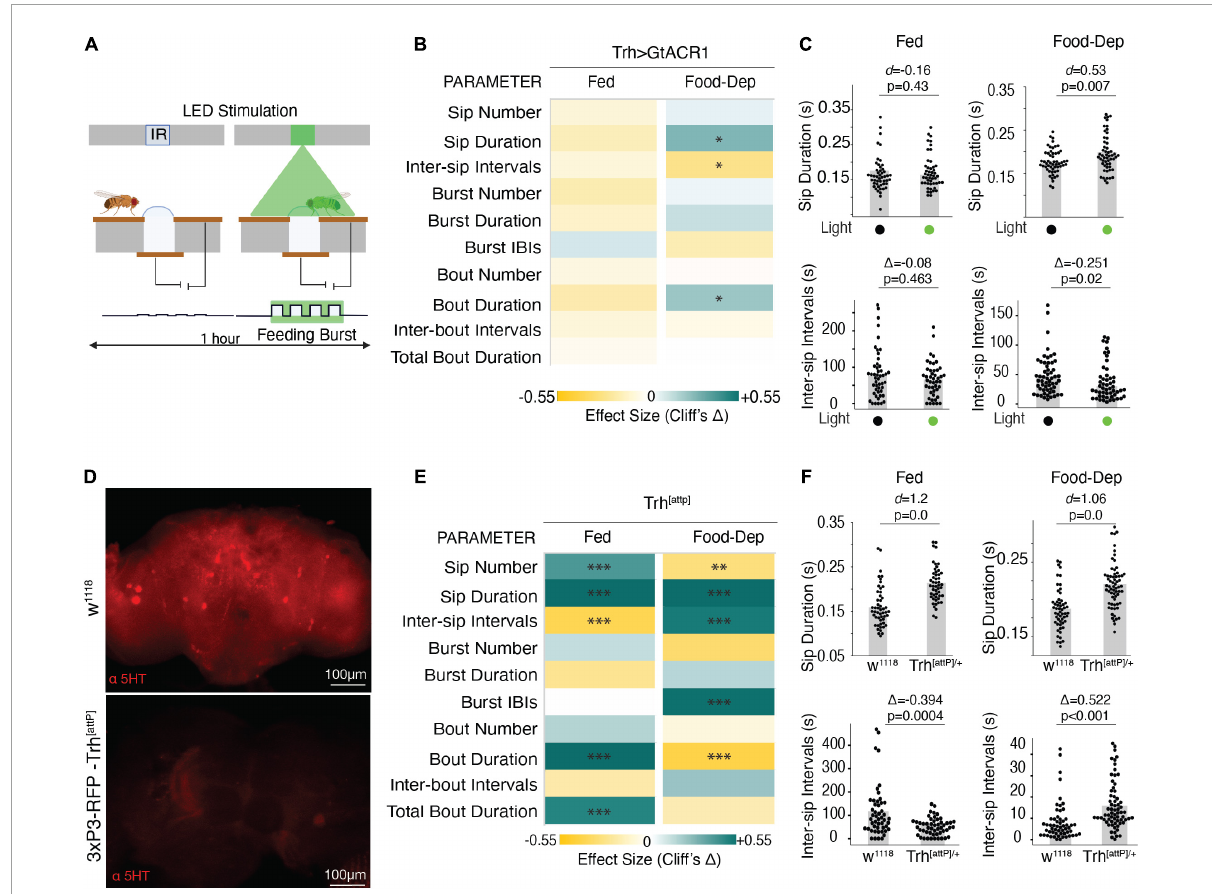
FIGURE4 The inactive serotonergic system enhances feeding. (A) Schematic depicting the closed-loop OptoPAD system used for optogenetic inactivation of serotonergic neurons as the fly starts to feed. The green illumination lasts for 2 s after the start of the activity bout. (B) Heat maps showing Cliff’s (cid:49) effect sizes for all the parameters measured by the OptoPAD system for Trh-Gal4 > UAS-GtACR1 with and without green illumination for the fed state and the food-deprived state. (C) Cumming estimation plots showing Cohen’s d for mean sip durations and Cliff’s (cid:49) for inter-sip intervals of Trh-Gal4 > UAS-GtACR1 flies in the fed state (left) and food-deprived state (right) with and without optogenetic activation during the assay time (3,600 s). Inactivation of Trh neurons at 100 uW/mm 2 increased the sip duration [ n = 54–55, d = 0.53, (95% CI 0.15, 0.89), p = 0.0074] and decreased the inter-sip intervals [ n = 52–57, (cid:49) = –0.265 (95.0% CI –0.46, –0.03), p = 0.018] in the food-deprived state. (D) Maximum intensity projections of anti-5-HT staining of fly brains with normal expression of Trh (wild-type) and flies carrying the attP mutation. (E) Heat map showing Cliff’s (cid:49) effect size for the parameters measured by the OptoPAD system for Trh-attp/ + compared to w 1118 controls for the fed and food-deprived states. (F) Cumming estimation plot showing Cohen’s d for mean sip durations and Cliff’s (cid:49) for inter-sip intervals for Trh-attP/ + flies compared with w 1118 flies in the fed state (left) and the food-deprived state (right) during the assay time (3,600 s). The Trh mutants showed an increased sip duration [ n = 50–51, d = 1.2, (95% CI 0.72, 1.66), p < 0.0001] and a decrease in the inter-sip intervals [ n = 49–51, (cid:49) = –0.394 (95.0% CI –0.593, –0.16), p = 0.0004] in the fed state. The Trh mutants showed an increased sip duration [ n = 57–65, d = 1.06, (95% CI 0.67, 1.42), p = 0.0], and the inter-sip intervals [ n = 57–67, (cid:49) = 0.522 (95.0% CI 0.328, 0.677), p < 0.0001] in the food-deprived state. In the heatmap, green indicates an increase in effect size, and yellow indicates a decrease in effect size. p -values for the effect size measure are indicated with an asterisk ∗ p < 0.05, ∗∗ p < 0.01, and ∗∗∗ p <